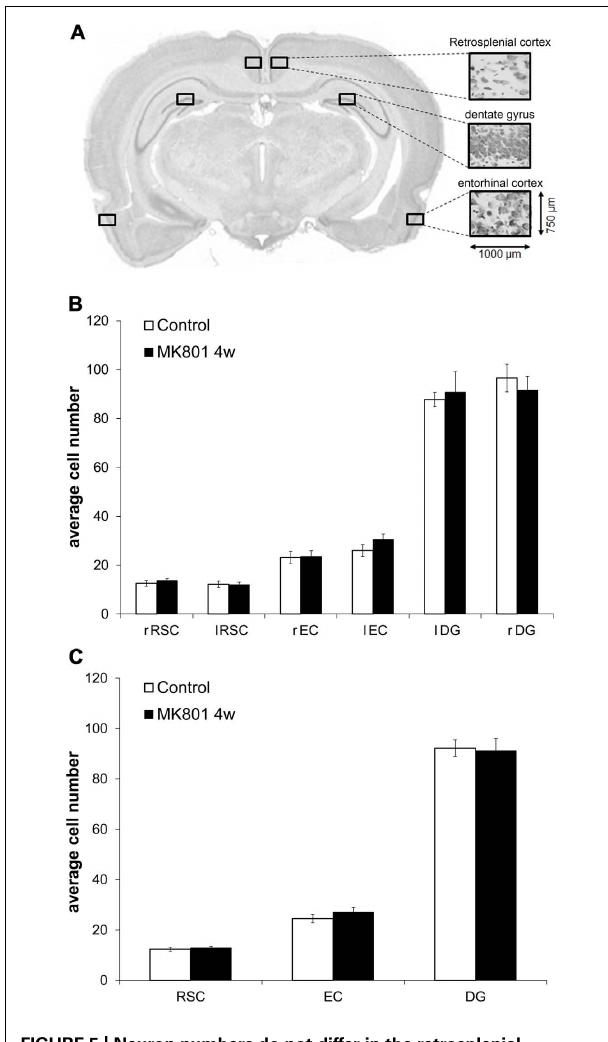
FIGURE 5 | Neuron numbers do not differ in the retrosplenial cortex (RSC), dentate gyrus (DG), and entorhinal cortex (EC) when tissue from vehicle- and MK801-injected animals is compared 4 weeks after treatment. (A) Representative example of the section plane analysed ( − 5.3 respect to Bregma) with the predefined regions of interest (ROIs) of the same size (750 μ m × 1000 μ m) in the left and right hemispheres. (B , C) Average cell numbers do not differ between controls and MK801-treated animals 4 weeks after injection. RSC, retrosplenial cortex; DG, dentate gyrus; EC, entorhinal cortex; r, right; l,